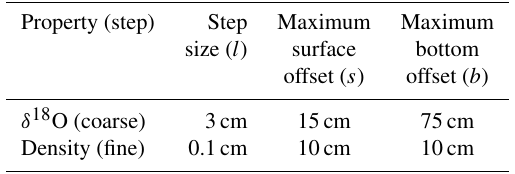
Table 2. Fitting parameters for our adaption of the DTW